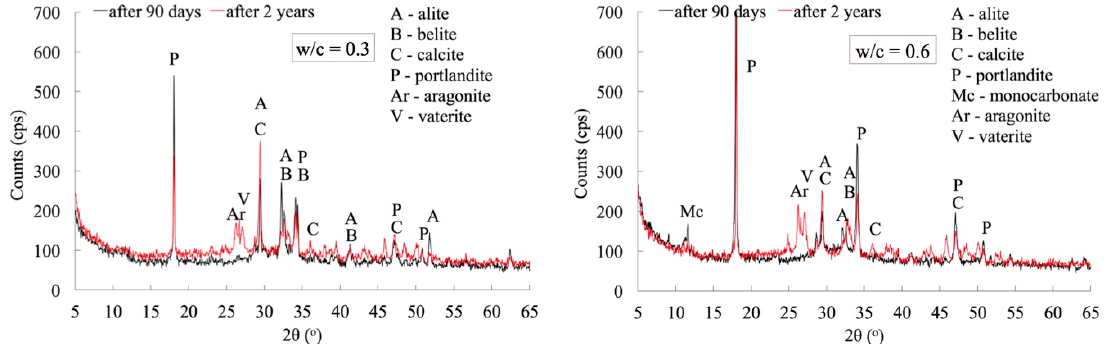
Figure 8. X-ray pattern of cement pastes with w/c ratios of 0.3 and 0.6 after 90 days and 2 years of curing.